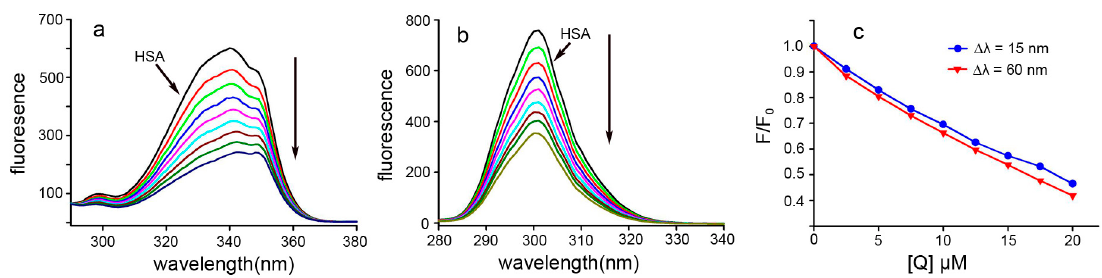
Figure 8. Effects of Dp44mT on the synchronous fluorescence spectra of HSA at 298 K. ( a ) Δλ = 60 nm; ( b ) Δλ = 15 nm; and ( c ) the effects of Dp44mT on Trp and Try fluorescence. C HSA = 15.0 μ M.